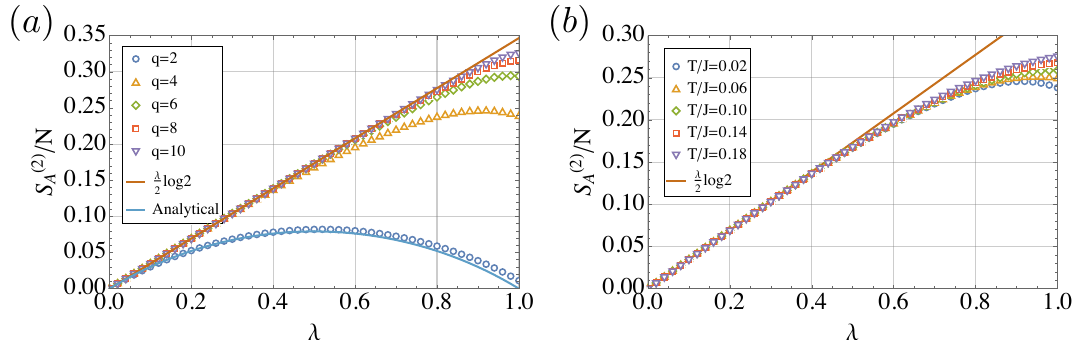
(cid:112) 2, which 2 ( 2 ) / N for different A